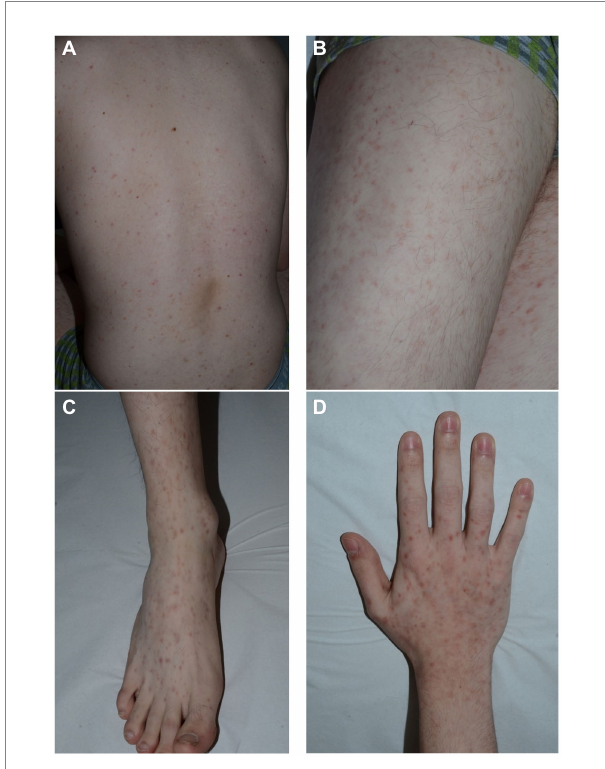
FIGURE 2 Patient 6. Erythematous maculopapular exanthem involving the trunk (A) , the limbs (B) and the acral sites (C,D)